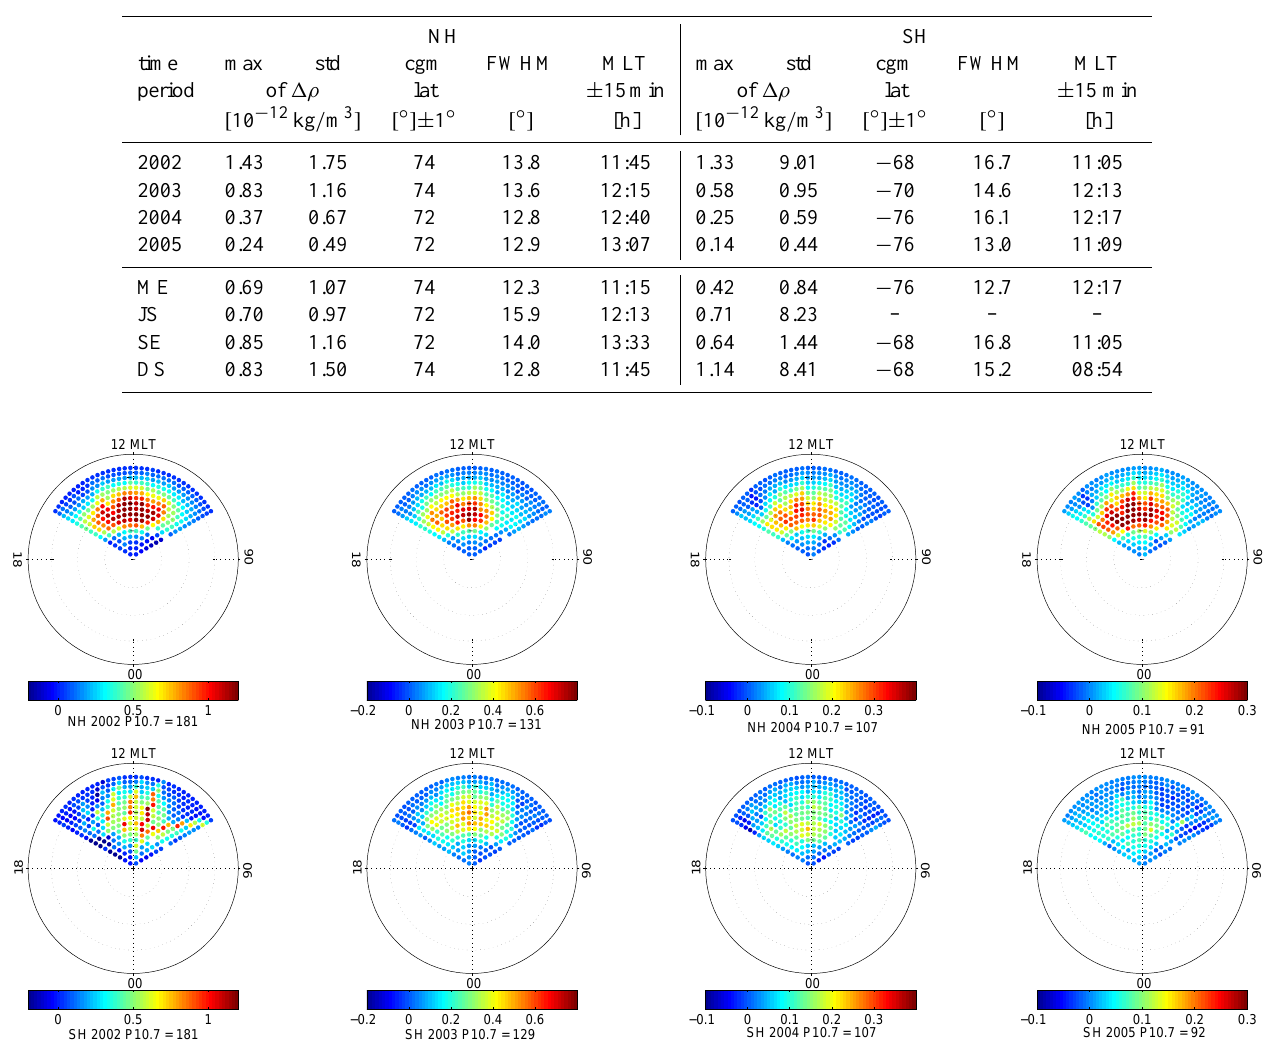
Table 1. Peak and standard deviation (std) of the longitudinally averaged amplitude, its cgm latitude, full latitudinal width at half maximum (FWHM) and the magnetic local time (MLT) of the density anomaly peak in the Northern (NH) and Southern (SH) Hemisphere for the different years and seasons. The standard deviation and the mean error of the average of the FWHM amount to about 10 ◦ and 2 . 43 ◦ in latitude in all cases, respectively.